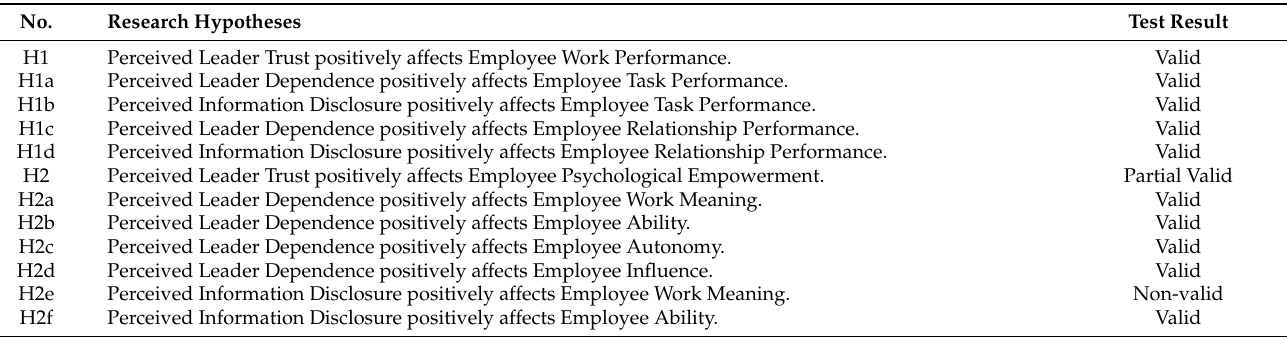
Table 27. Summary of Research